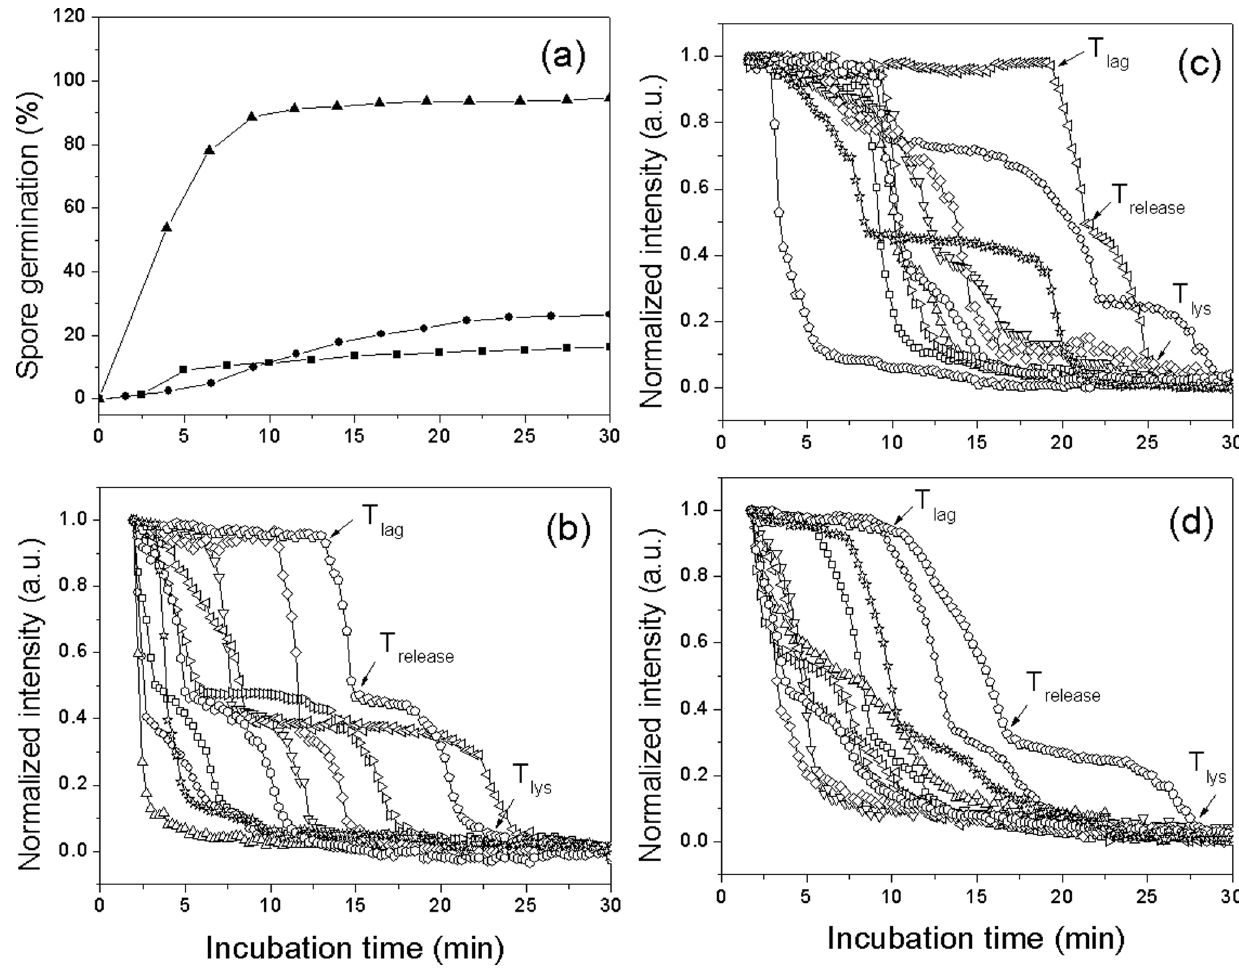
Figure 5. Germination of multiple individual G.stearothermophilus spores with AGFK at different temperatures. Heat activated (30 min, 100 u C) spores were germinated at various temperatures with AGFK and 10 mM sodium phosphate buffer (pH 8.0), and germination of individual spores was monitored by DIC microscopy as described in Methods. Germination of $ 220 individual spores at 65 u C ( m ), 55 u C ( shown in (a). Kinetics of germination of ten individual spores at 65 u C (b), 55 u C (c), or 45 u C (d) was given in